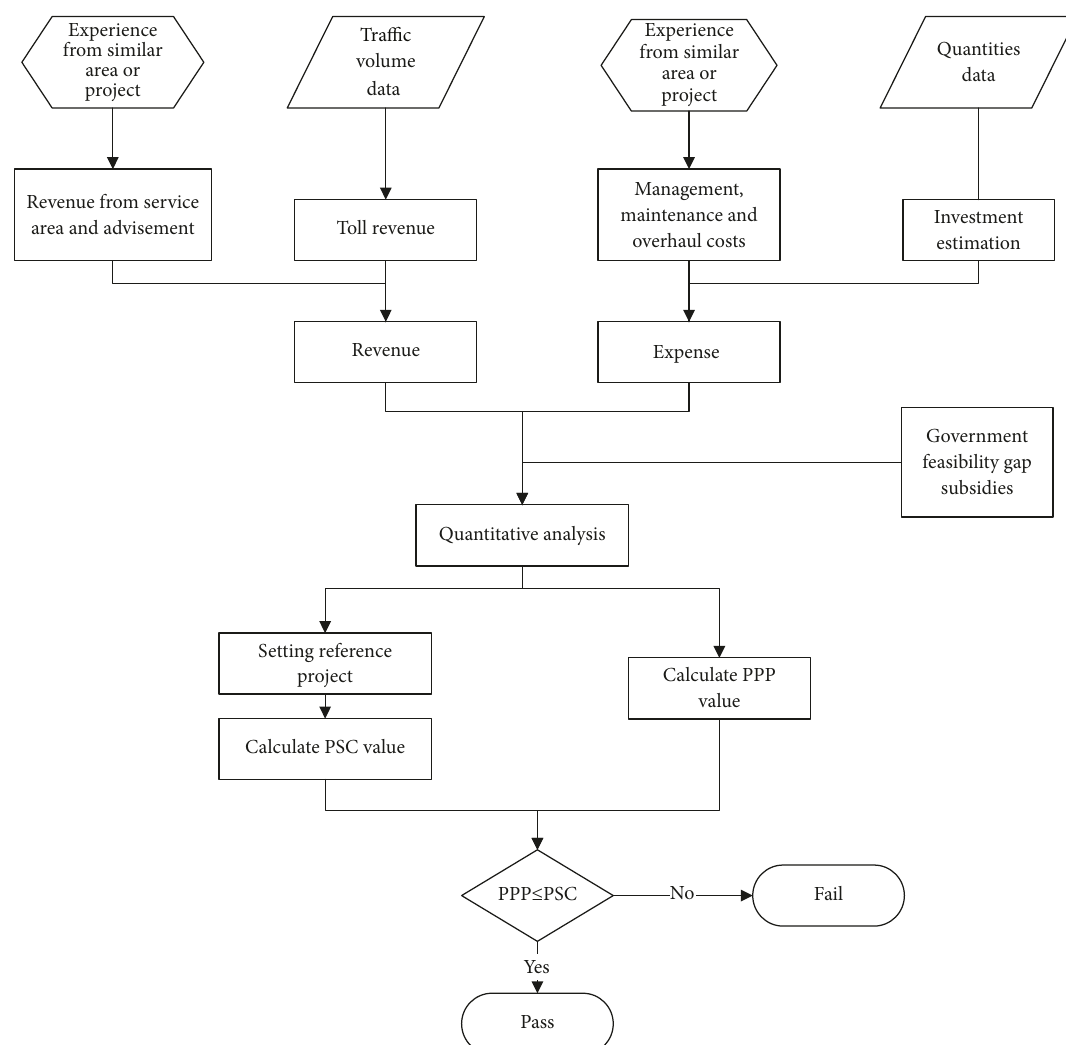
Figure 1: The quantitative evaluation process of a highway project under the PPP mode.